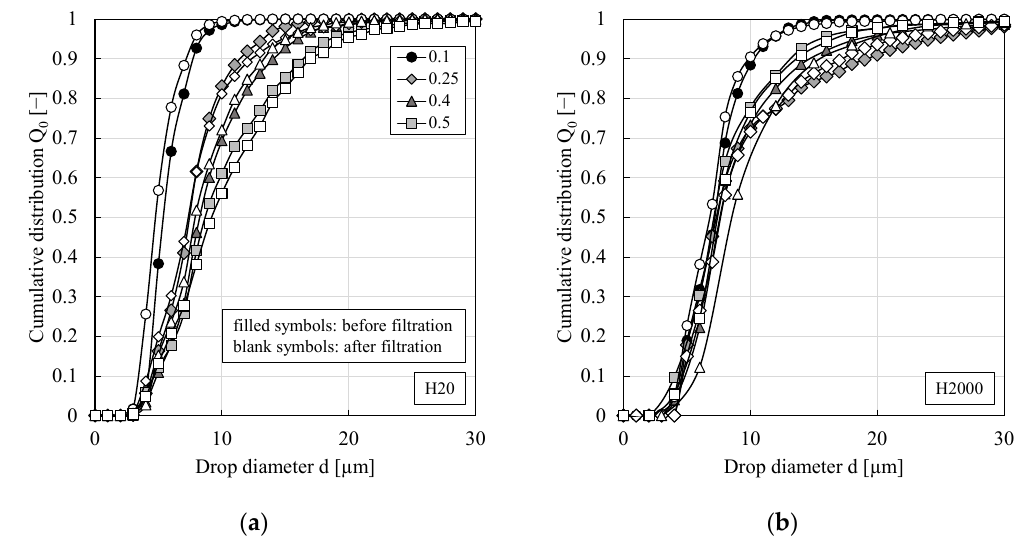
Figure 3. Cumulative distribution for w/o PEs stabilized by 0.5 wt.% of particle type ( a ) H20 or ( b ) H2000 and different dispersed phase fractions before and after the filtration. All experiments were performed at least in duplicate and mean values are shown. For better graph clarity, error bars are not shown but were always below 25%.